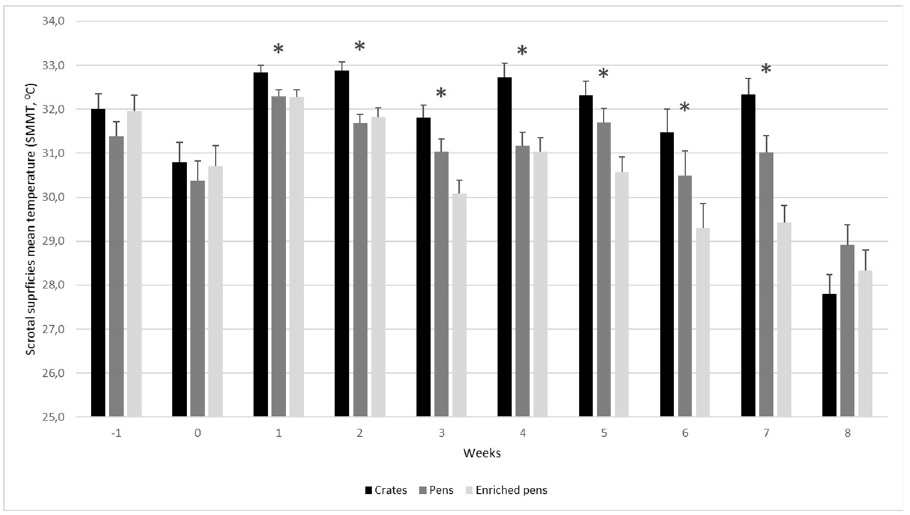
Fig 3. Mean environment temperature and mean humidity collected by a data logger (OPUS 20 THI, 8120.00; Lufft, Germany) at the moment of thermal pictures collection.